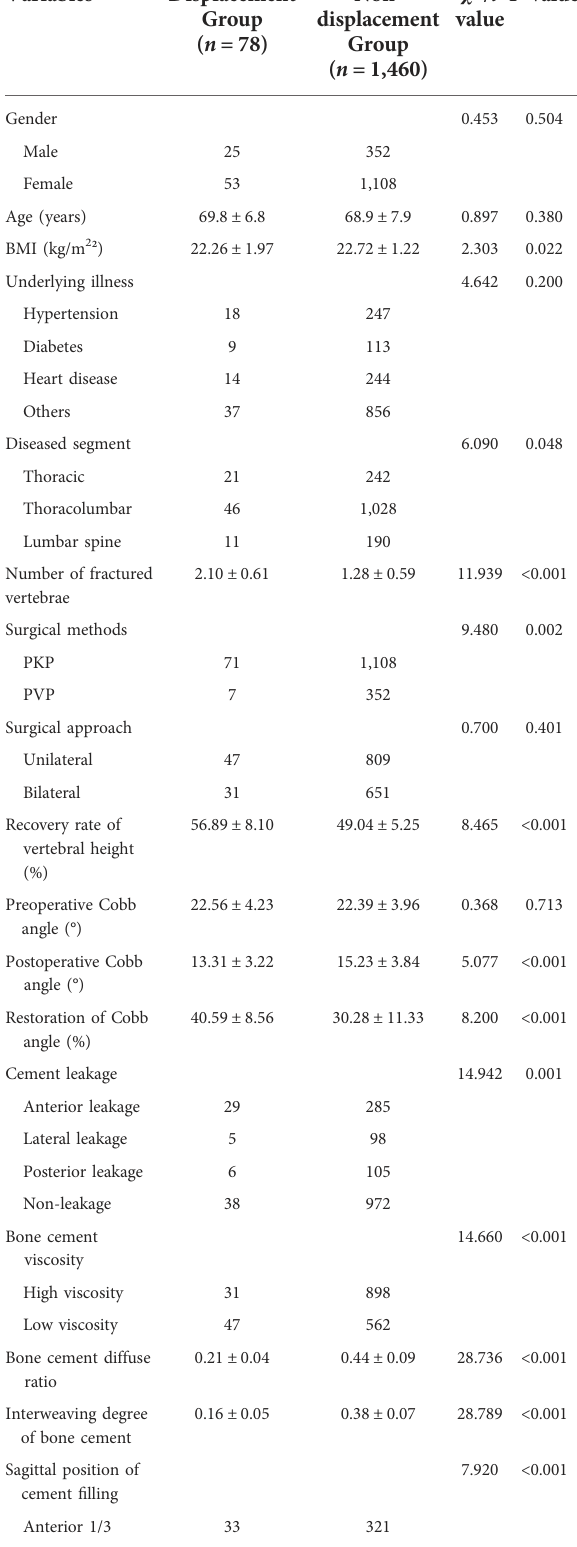
TABLE 1 Univariate analysis of postoperative bone cement